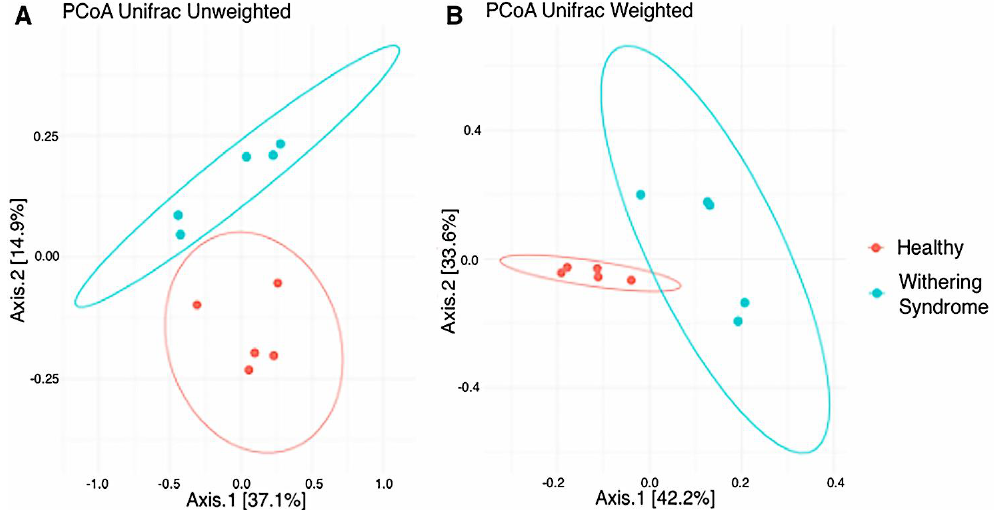
Figure 2. Principal coordinates analysis (PCoA) of the bacterial communities derived from the unweighted ( A ) and weigthed ( B ) UniFrac distance matrix. Circles represent individual samples from red abalone digestive gland microbiota. Red circles correspond to samples from healthy abalones ( n = 5) and blue light circles correspond to samples from red abalones a ff ected with withering syndrome disease ( n =